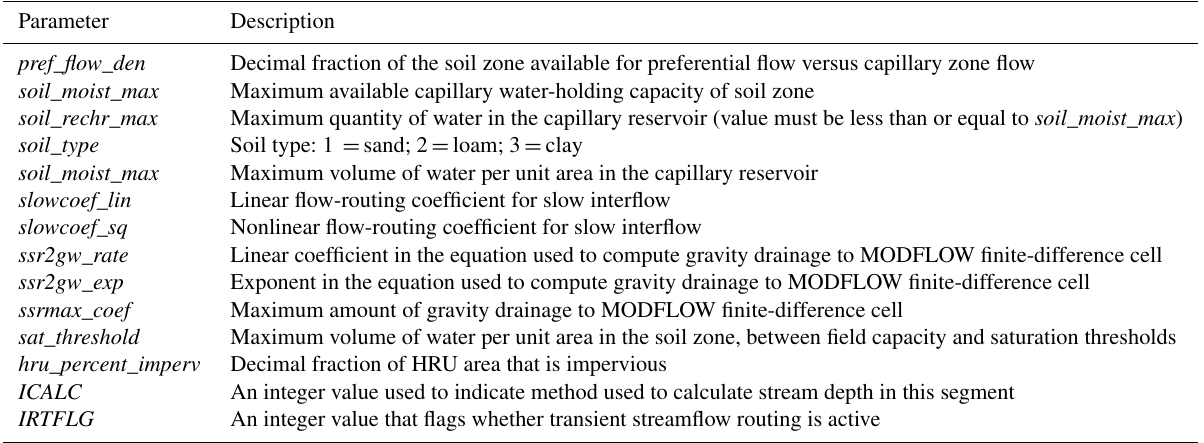
Table 1. Select GSFLOW parameters (adapted from Markstrom et al., 2008, Appendix 1).